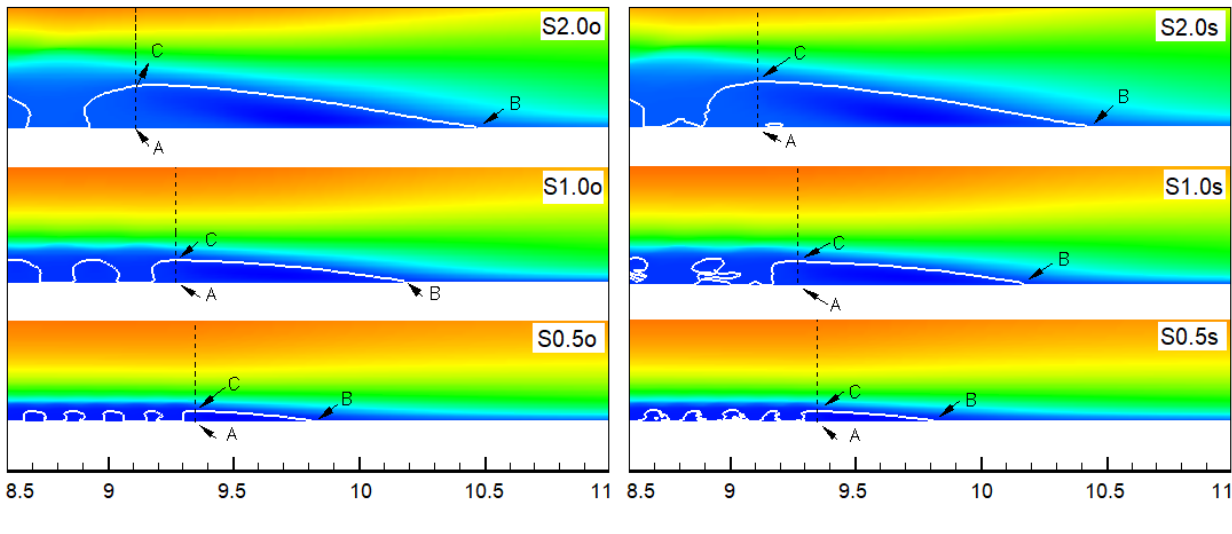
Figure 7. Contours of the time-averaged streamwise velocity in the ‘x-y’ plane. One can notice that in the case of the smallest spheres (S05o and S0.5s), the arrange- ment of the spheres (one after another or shifted) has no impact on the size of the recir- culation zone. Differences are seen only when the sphere diameter is larger. In general, when the spheres are placed one after another, the recirculation zone is greater, whereas when the sphere rows are shifted, the recirculation zone is longer. In effect, the inclina- tion angles of their upper border, approximately reflected by the ratio | AC | / | AB | , change significantly. For instance, for the cases S2.0o and S2.0s, the difference in respect to the mean value ( | AC | / | AB | mean = 0.136) reaches 15%. The overall region of the